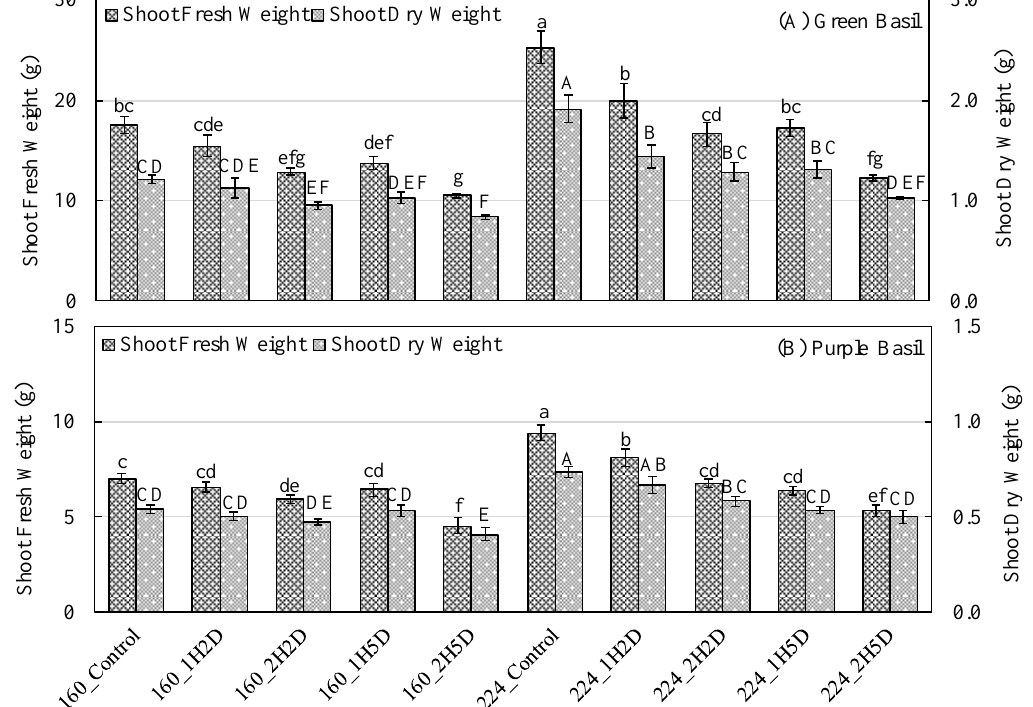
Figure 4. Shoot fresh weight and shoot dry weight of green basil ‘Improved Genovese Compact’ plants ( A ), and purple basil ‘Red Rubin’ plants ( B ) under di ff erent treatments. There were 10 treatments created by the combination of two photosynthetic photon flux density (PPFD) of 160 and 224 µ mol · m − 2 · s − 1 and five UV-B radiation treatments including control, 1H2D, 2H2D, 1H5D, 2H5D. Means followed by the same lower / upper case letters are not significantly di ff erent for green / purple plants, according to Student’s t mean comparison ( p < 0.05). Bars represent standard